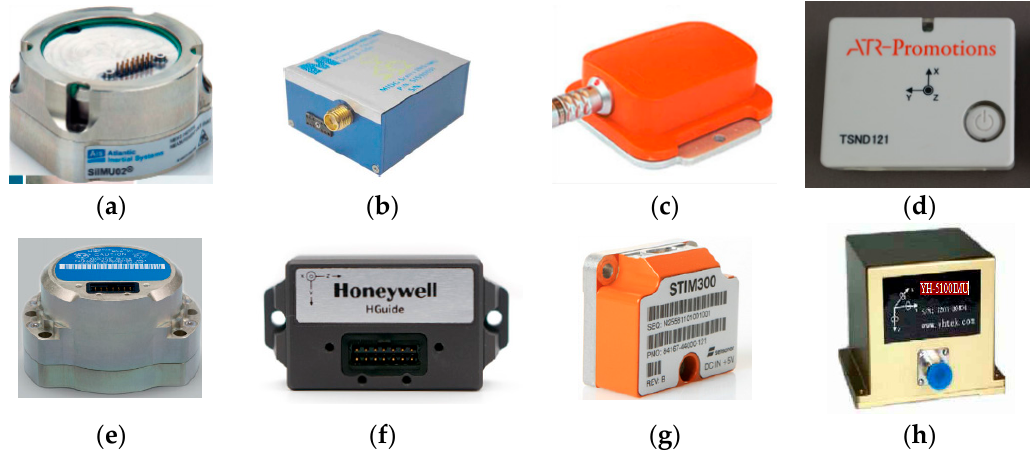
Figure 6. Some typical MIMUs used for pipeline surveying. ( a ) SiIMU02 IMU; ( b ) MIDG II IMU; ( c ) Xsens MTi IMU; ( d ) TSND121 IMU; ( e ) HG4930 IMU; ( f ) HGi300 IMU; ( g ) STIM300 IMU; ( h ) YH-5100 IMU.